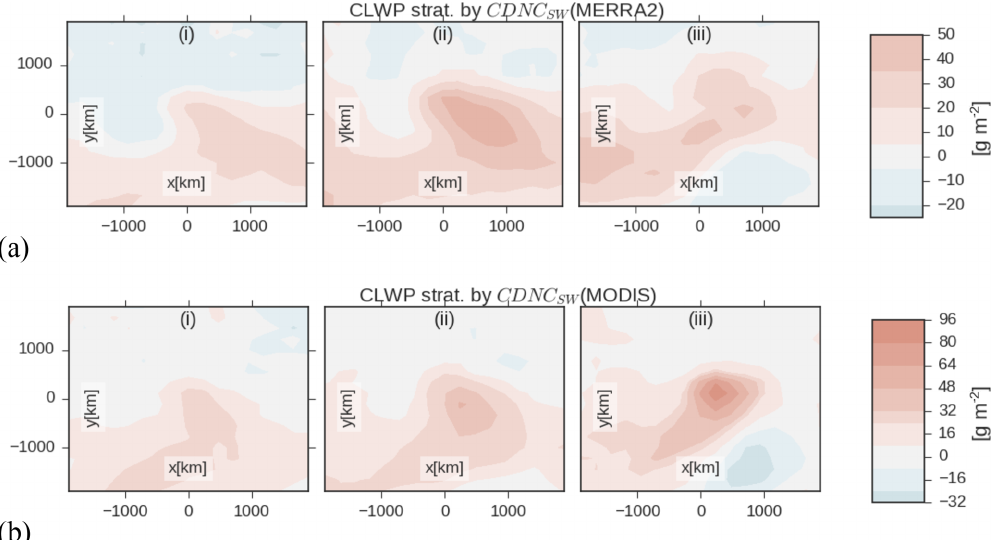
Figure 7. The difference in cyclone composited MAC-LWP CLWP between the top and bottom third of CDNC SW inferred from MERRA2 (a) and retrieved by MODIS (b) . Composites are shown split into WCB quantiles as in Fig.